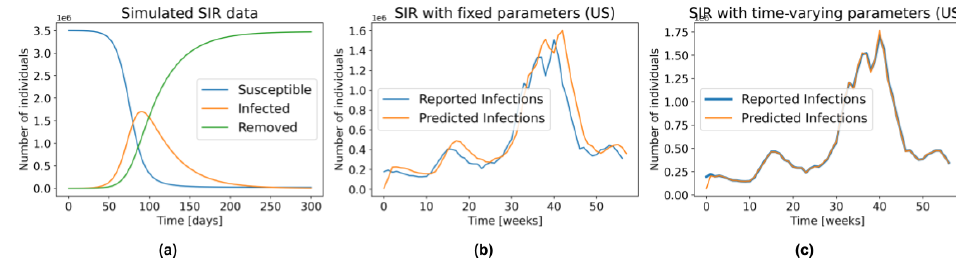
Figure 1. ( a ) General behaviour of the SIR model. ( b ) The number of infections predicted by the SIR model with fixed parameters, fitted to the US data for 1 week prediction. ( c ) Similar to ( b ), but with time-varying